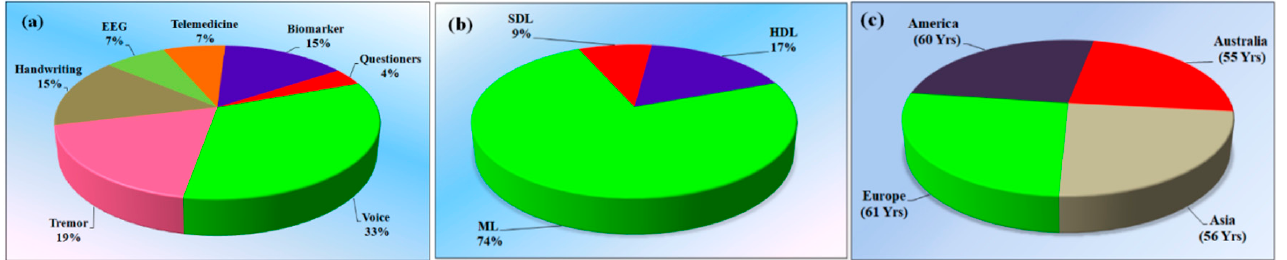
Figure 6. ( a ) Various kinds of input for the detection of the PD, ( b ) types of AI architectures, and ( c )